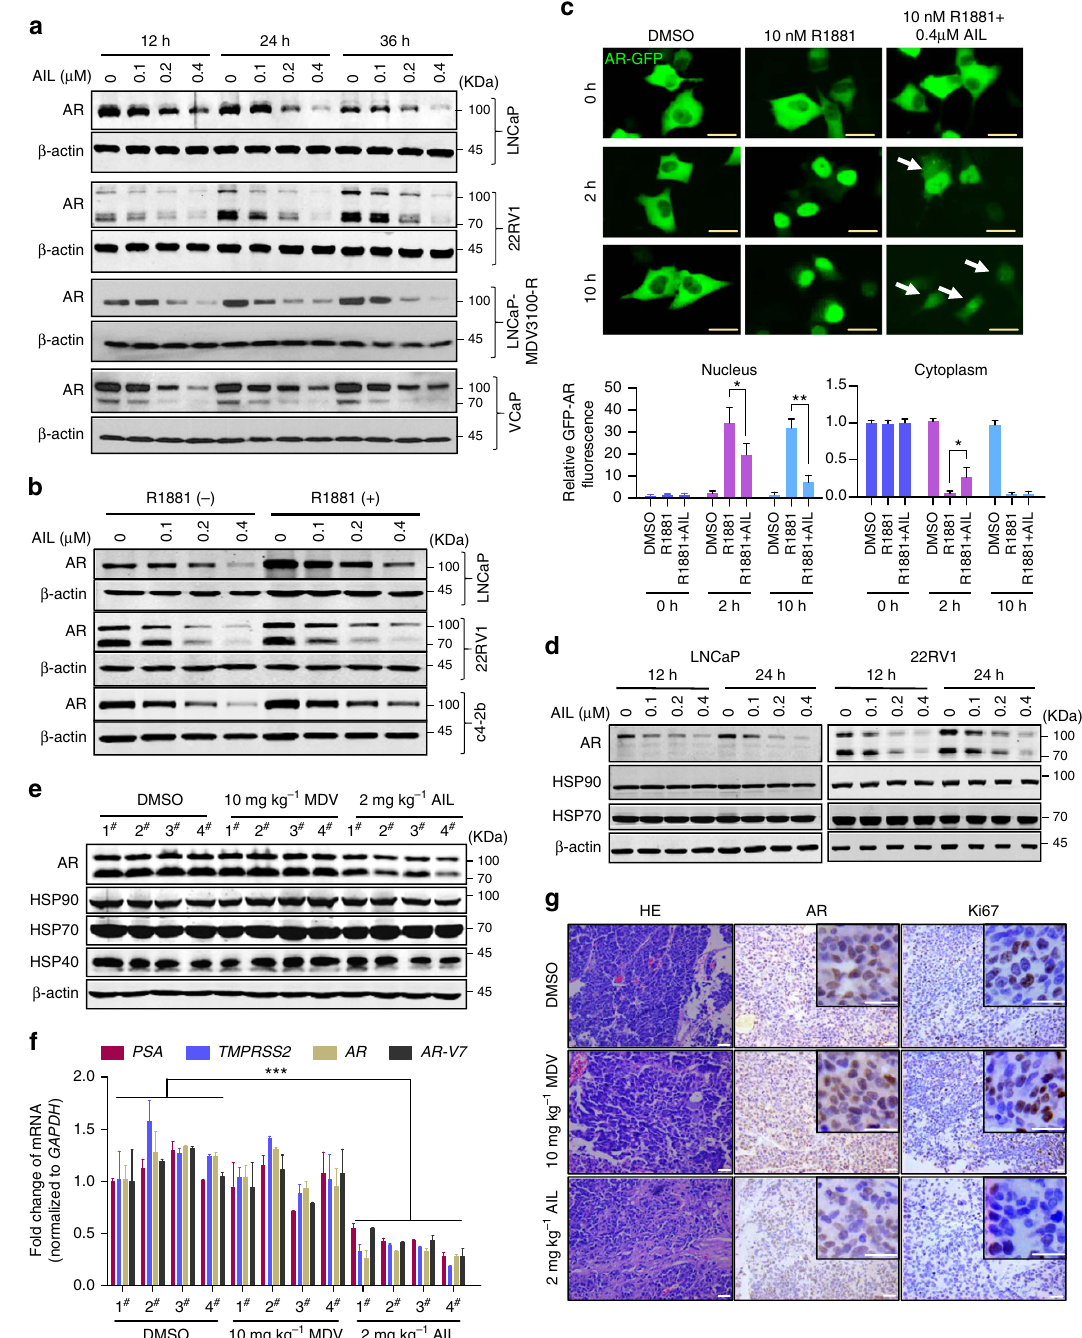
Figure 3 | Downregulation of AR protein levels in vitro and in vivo by AIL. ( a ) LNCaP, 22RV1, LNCaP-MDV3100-R and VCaP cells were treated with indicated concentrations of AIL for 12, 24 and 36h. Then cells were lysed and AR protein level was measured by western blotting analysis. ( b ) LNCaP, 22RV1 and c4-2b cells were treated for 12h with indicated concentrations of AIL with or without R1881 and the AR protein level was measured by western blotting analysis. ( c ) AR null PC3 cells were transfected with AR-GFP in serum-free conditions for 24h and treated with DMSO (control), R1881 (10nM) or combined AIL (0.4 m M) and R1881 (10nM). AR-GFP images were taken at 2 or 10h after treatment. Five pictures were randomly selected and the GFP-AR fluorescence in cytoplasm and nucleus was quantitated using Image-Pro Plus 4.5 software (Media Cybernetics, Silver Spring, USA). The arrows indicate the location of AR-GFP. Data were expressed as mean ± s.d.; Student’s t -tests were performed; * P o 0.05, ** P o 0.01. Scale bars, 10 m m. ( d ) LNCaP and 22RV1 cells were treated with the indicated concentrations of AIL for 12 and 24h. Cells were lysed and AR, HSP90 and HSP70 protein levels were measured by western blotting analysis. ( e ) Four representative tumour samples per group were lysed. AR, HSP90, HSP70 and HSP40 protein levels were measured by western blotting analysis. ( f ) The mRNA levels of PSA , TMPRSS2 , total AR and AR-V7 were measured by quantitative-PCR and normalized to GAPDH . The sequences of quantitative-PCR primers were listed in Supplementary Table 2. Data were expressed as mean ± s.d.; two-way ANOVA followed by Bonferroni multiple comparison test were performed; *** P o 0.001. ( g ) Photographs of xenografts treated i.p. with DMSO (control group), 10mgkg (cid:2) 1 MDV and 2mgkg (cid:2) 1 AIL with corresponding IHC for AR and Ki67. Scale bars, 20 m